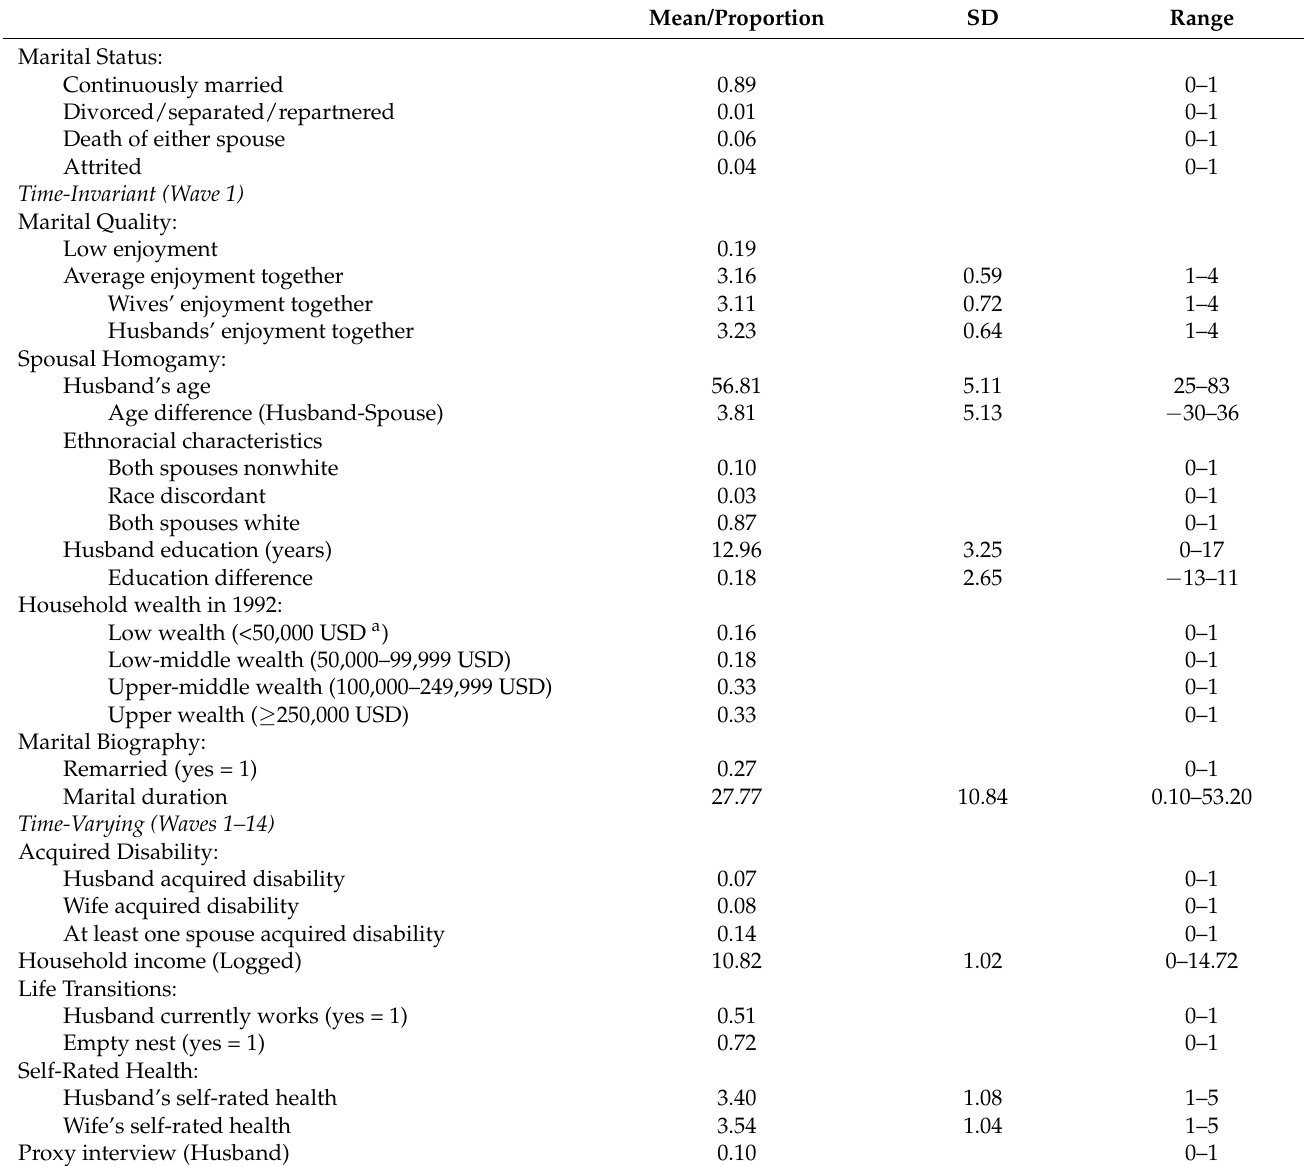
Table 2. Sample Characteristics of Analytic Sample (N = 29,487